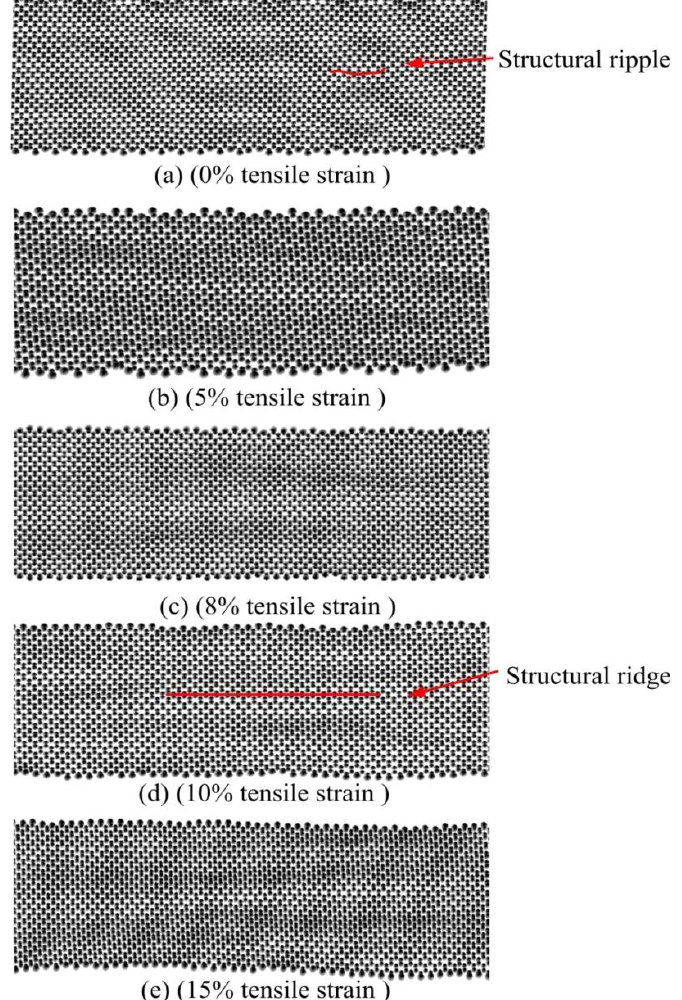
Figure 3. Graphene surface ripples change to ridges as the tensile strain increases: ( a ) 0% tensile strain; ( b ) 5% tensile strain; ( c ) 8% tensile strain; ( d ) 10% tensile strain; ( e ) 15% tensile